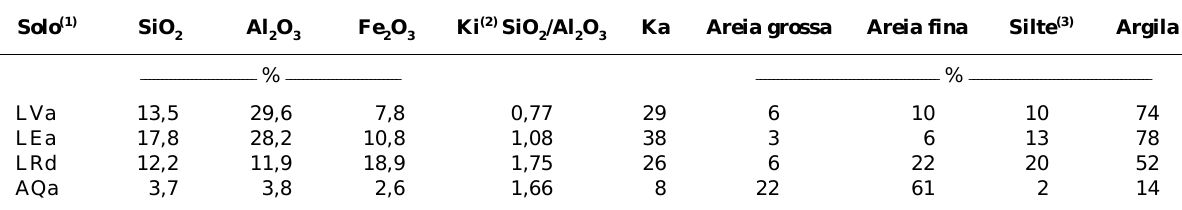
Quadro 2. Elementos totais, índice de intemperismo (Ki), teores estimados de caulinita (Ka) e